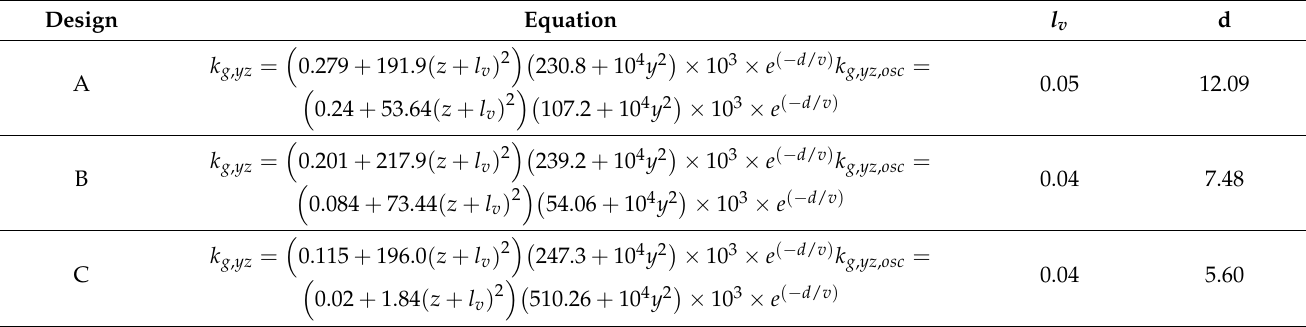
Table 9. Mathematical expressions of the guidance stiffness.